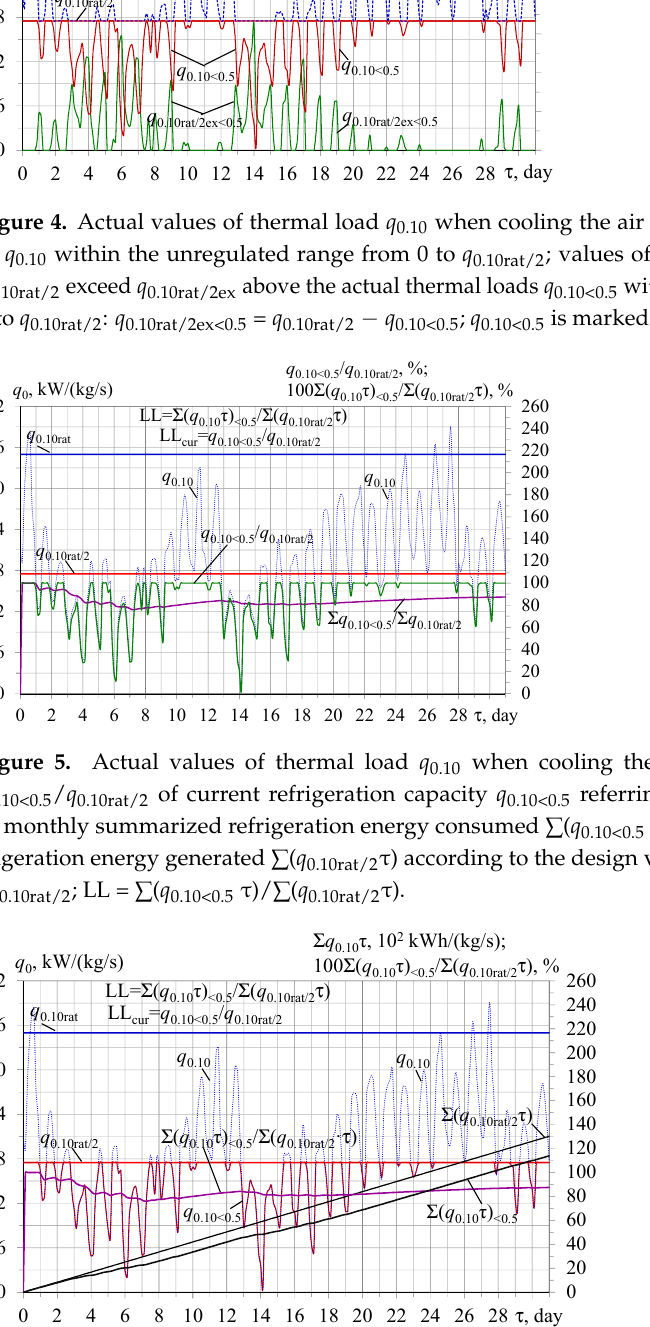
Figure 5. Actual values of thermal load q 0.10 when cooling the air to 10 ° С ; relative values q 0.10 ˂ 0.5 / q 0.10rat/2 of current refrigeration capacity q 0.10 ˂ 0.5 referring to q 0.10rat /2; relative values of monthly summarized refrigeration energy consumed ∑ ( q 0.10 ˂ 0.5 τ )/ ∑ ( q 0.10rat/2 τ ) referring to refrigeration energy generated ∑ ( q 0.10rat/2 τ ) according to the design value q 0.10rat /2: LL cur = q 0.10 ˂ 0.5 / q 0.10rat/2 ; LL = ∑ ( q 0.10 ˂ 0.5 τ )/ ∑ ( q 0.10rat/2 τ ). Figure 6. Actual values of thermal load q 0.10 when cooling the air to 10 ° С ; the rest parts q 0.10 ˂ 0.5 of q 0.10 within the unregulated load range; summarized refrigeration energy consumed ∑ ( q 0.10 ˂ 0.5 τ ); generated ∑ ( q 0.10rat/2 τ ) according to rational value q 0.10rat /2 within the unregulated load range and relative values of summarized refrigeration energy consumed ∑ ( q 0.10 ˂ 0.5 τ )/ ∑ ( q 0.10rat/2 τ ): LL = ∑ ( q 0.10 ˂ 0.5 τ )/ ∑ ( q 0.10rat/2 τ ).